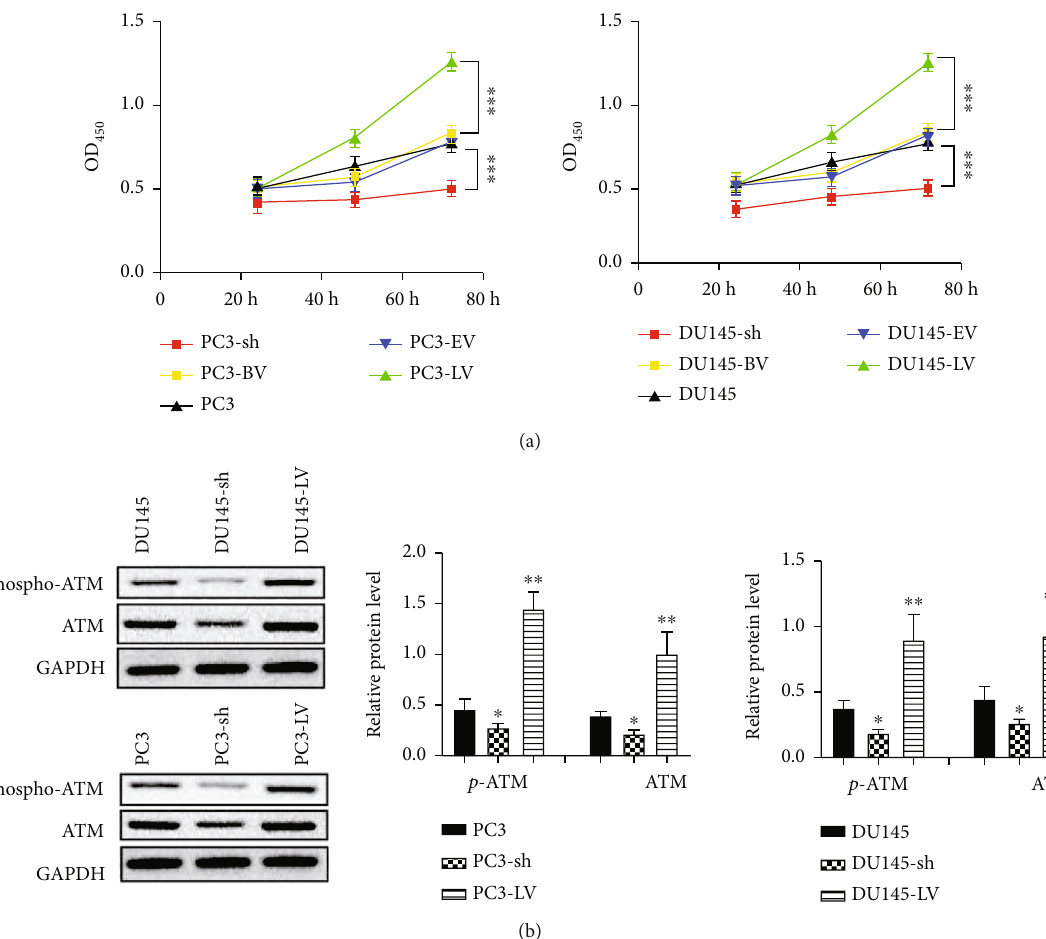
Figure 4: E ff ect of overexpression and MUS81 silencing on CRPC cell proliferation and its relationship with ATM protein levels. (a) CRPC cell proliferation. (b) The relative phospho-ATM and ATM protein expression. ∗ P < 0 : 05 and ∗∗ P < 0 : 01 , compared with PC3 cells. ∗∗∗ P < 0 : 001